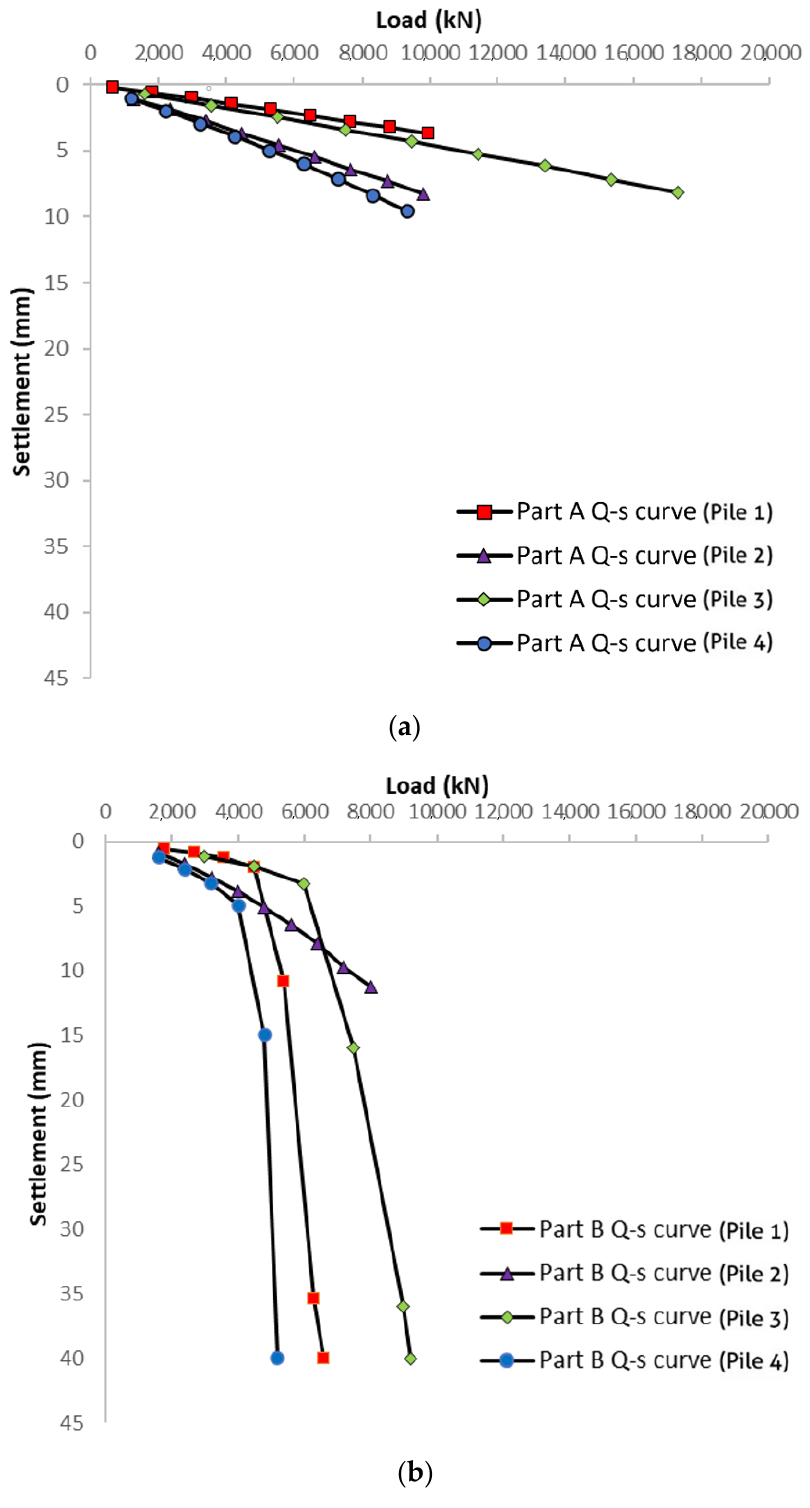
Figure 9. Interpreted load–settlement response of ( a ) upper part (Part A) ( b ) middle part (Part B).